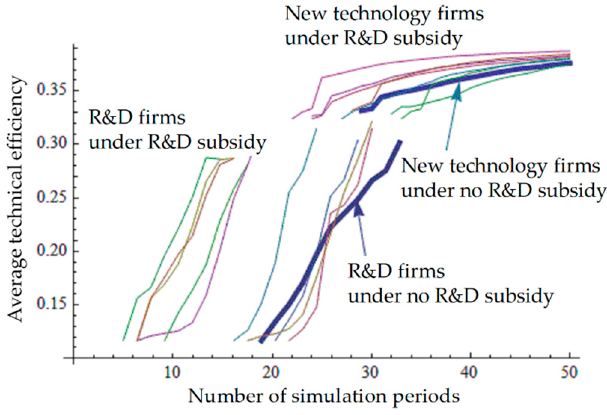
Figure 13. Impact of the R&D subsidy for R&D firms and new technology firms on average technical efficiency.